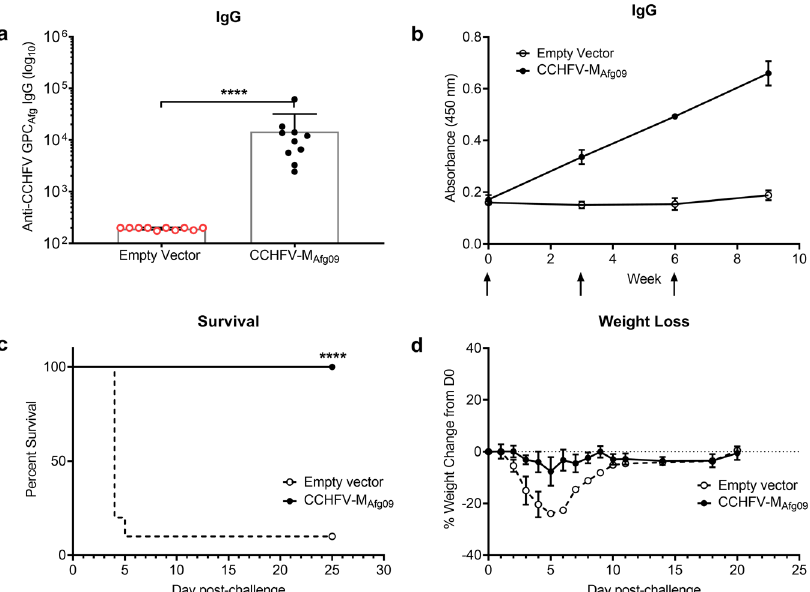
Fig. 8 CCHFV-M Afg09 DNA vaccination is completely protective against homologous challenge. Groups of 10 female C57BL/6 mice were vaccinated with 50 μ g CCHFV-M Afg09 or empty vector on days 0, 21, and 42 by IM-EP. a Sera antibody responses were analyzed 21 days post third vaccination for anti-CCHFV-Afg09-2990 endpoint titers by ELISA. Mice that succumbed to viral challenge are shown in red. b Temporal anti-CCHFV-Afg09-2990 IgG responses in vaccinated mice. The arrows indicate DNA vaccination time points. c Group survival and ( d ) weight change following CCHFV challenge with 100 PFU by the IP route with CCHFV-Afg09-2990. Vaccinated C57BL/6 mice were transiently immunosuppressed prior to challenge. Data are the group mean averages ± SD. **** p < 0.0001. The endpoint titer p value was determined by Student ’ s t test with a 95% con fi dence interval. The p value for percent survival was determined by log rank test with a 95% con fi dence CCHFV-Afg09-2990 GPC-speci fi c antibodies (Fig. 8a, b). Four weeks after the fi nal vaccination, all remaining mice were treated by IP injection of mAb-5A3 and challenged by 100 PFU of CCHFV-Afg09-